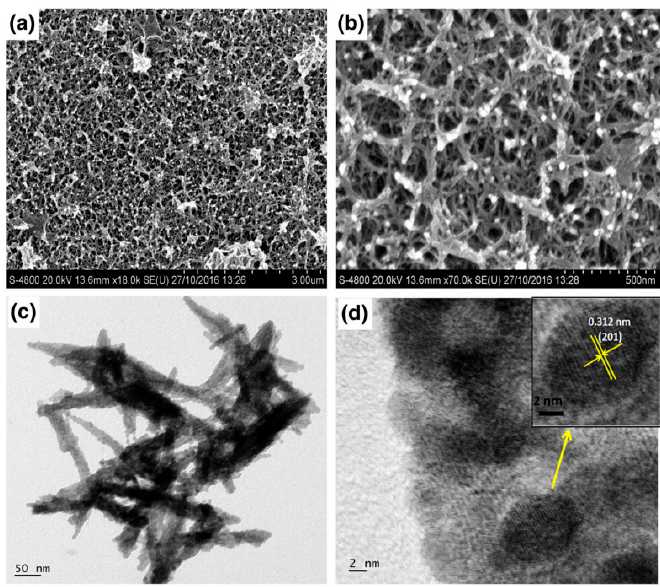
Figure 9. FESEM images of the SILAR-deposited Bi 2 O 3 films under two different magnifications ( a , b ). The TEM image ( c ) and the HRTEM image ( d ) of the Bi 2 O 3 scratch powder sample reproduced with permission from [179], Springer, 2017.